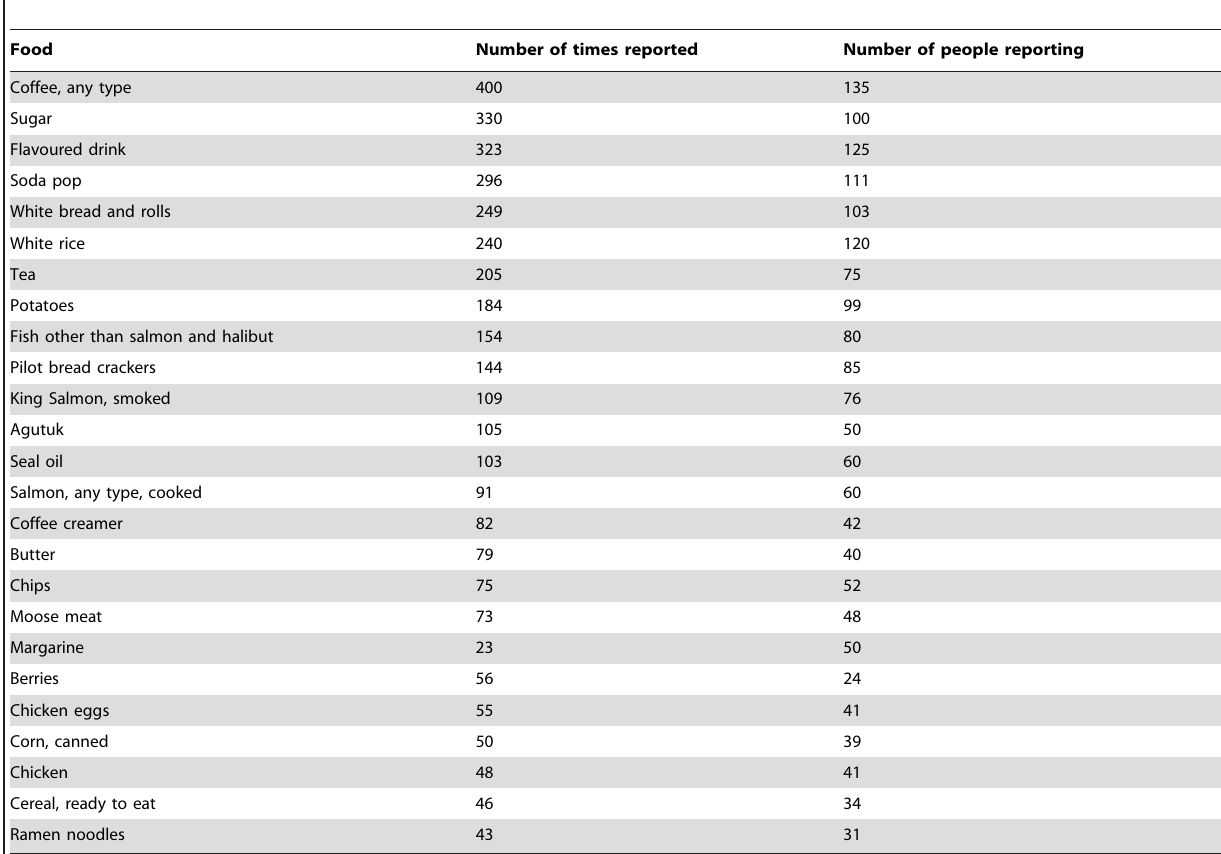
Table 1. Foods most commonly reported on 400, 24-hour recalls among Alaska Native people (n=177).